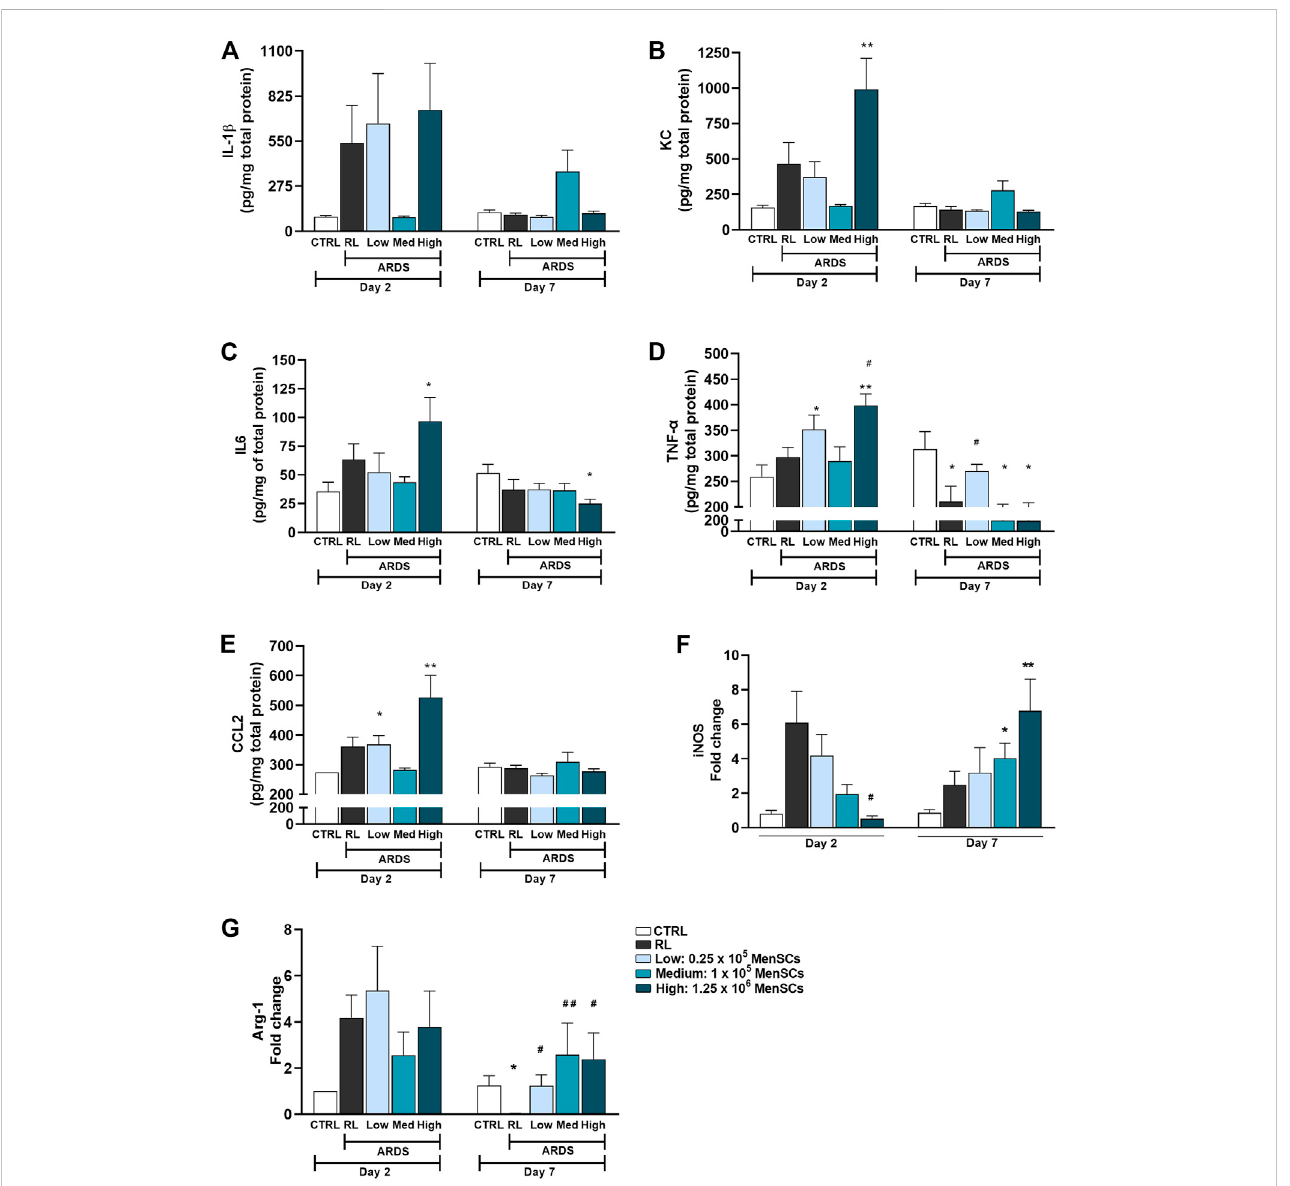
FIGURE 6 Cryopreserved MenSCs administration modulated in fl ammatory mediators. (A – E) Levels of in fl ammatory mediators determined by ELISA in lung tissue homogenates. Values are expressed as the mean ± standard error of the mean (SEM). (F , G) Expression of mRNA levels of iNOS and Arg-1. Data are expressed as fold change compared with the non-treated controls. Values are expressed as the mean ± SEM. *Signi fi cantly different from the CTRL group (* p ≤ 0.05, ** p ≤ 0.01). # Differentfrom theRLgroup ( # p ≤ 0.05, ## p ≤ 0.01). IL-1 β ,interleukin 1beta; KC,keratinocytes-derivedchemokine;IL6,interleukin6;TNF- α , tumour necrosis factor; CCL2, monocyte chemoattractant protein-1 (MCP-1); iNOS, inducible nitric oxide synthase; Arg1, arginase